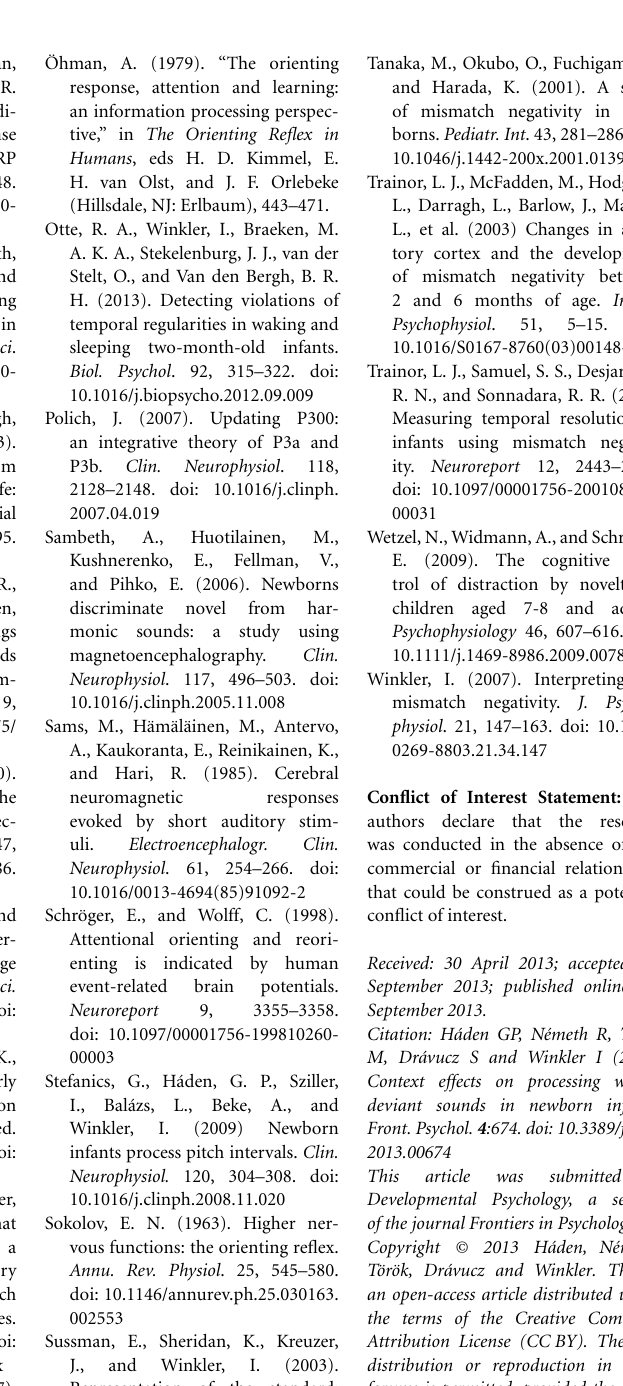
Representation of the standard: stimulus context effects on